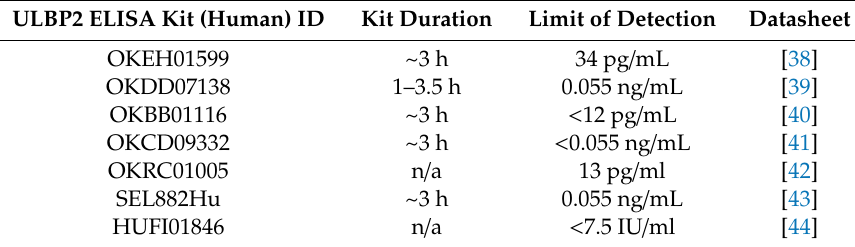
Table 4. ELISA Kit for the detection of ULBP2 in